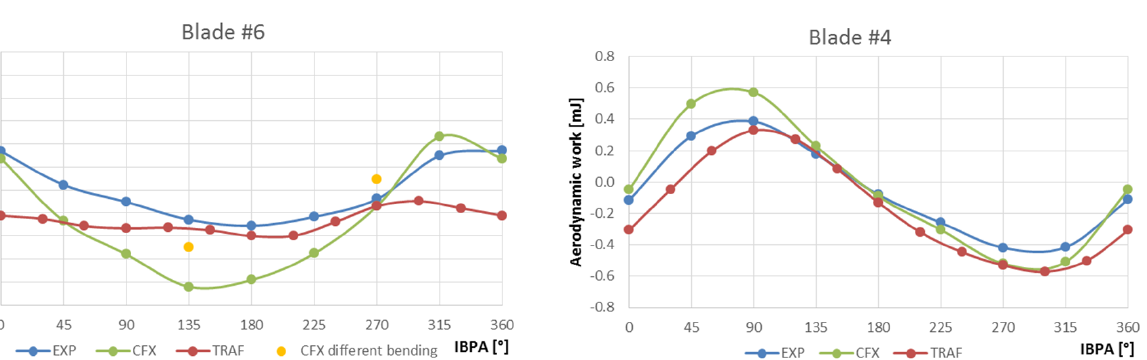
Figure 20. Aerodynamic work of blade torsion mo- tion - blade #4: experimental (EXP), CFX and TRAF comparison.